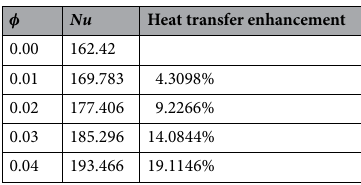
Table 4. Variation in the rate of mass transfer grease-based MoS 2 .